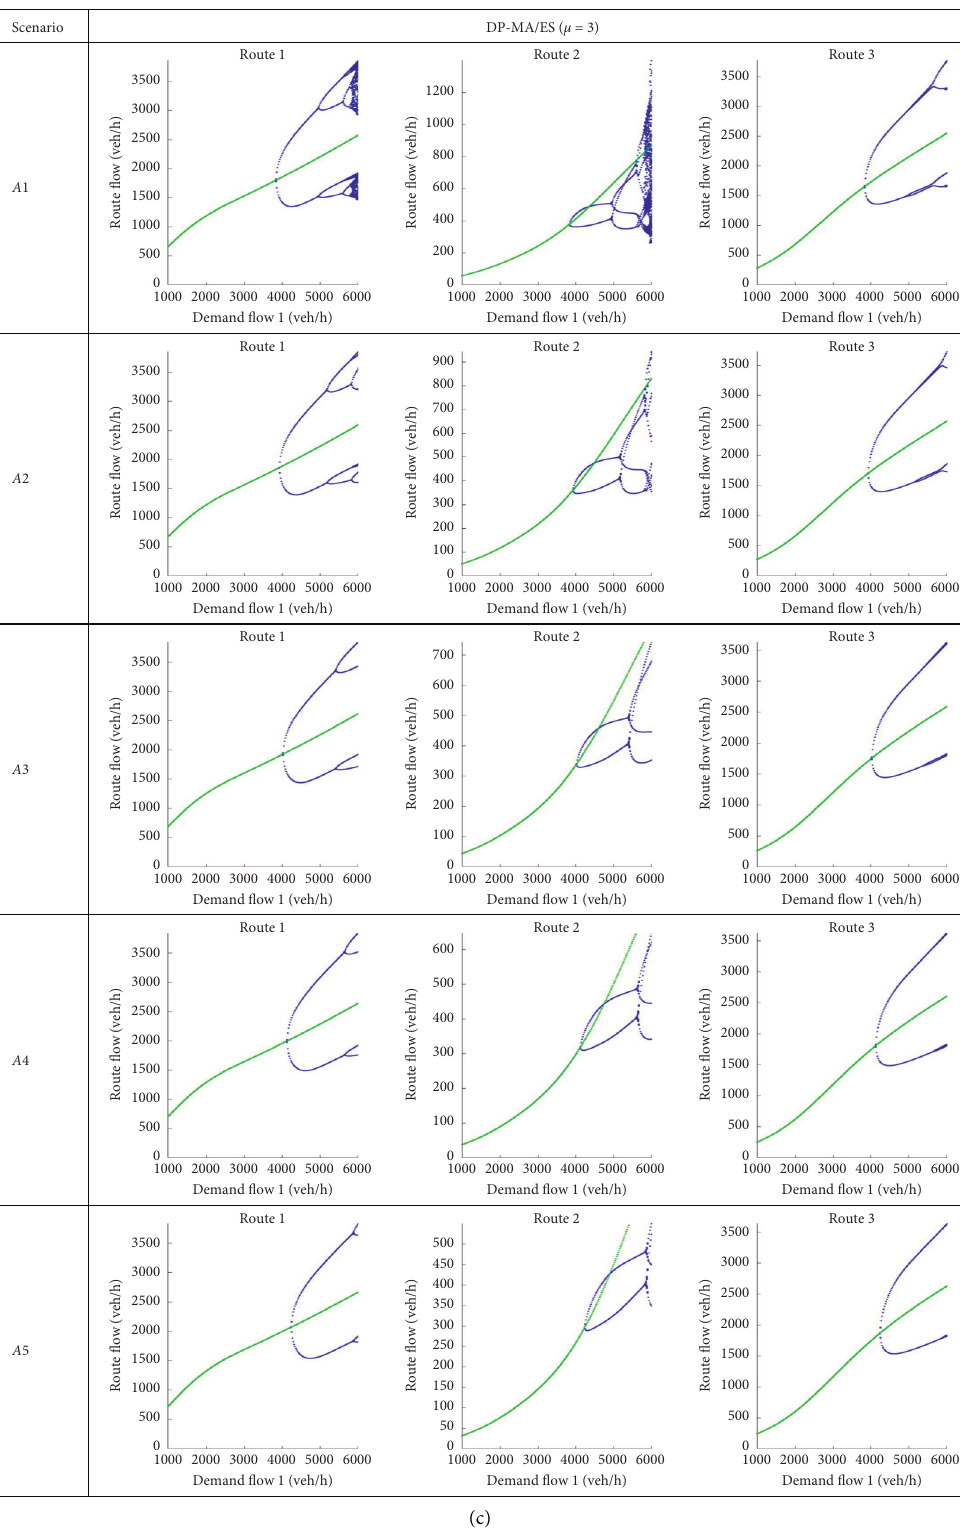
Figure 3: (a) Bifurcation diagrams of route flows, scenarios A, ES/ES. (b) Bifurcation diagrams of route flows, scenario A, MA/ES μ � 2. (c) Bifurcation diagrams of route flows, reference scenario, MA/ES μ �